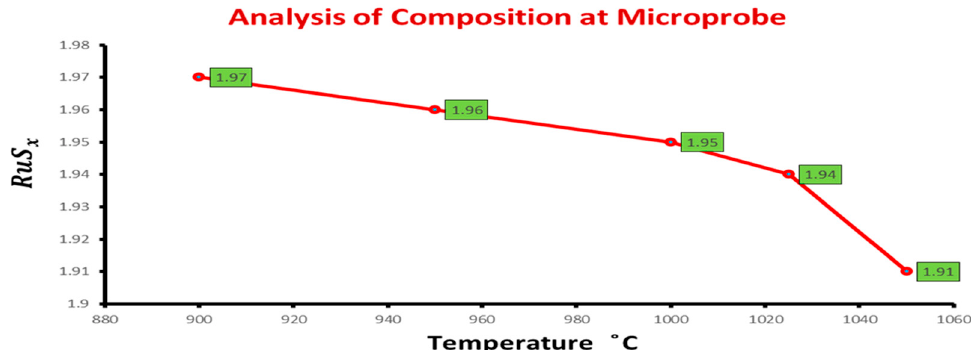
Figure 2. The effect of temperature on sulfur concentration.